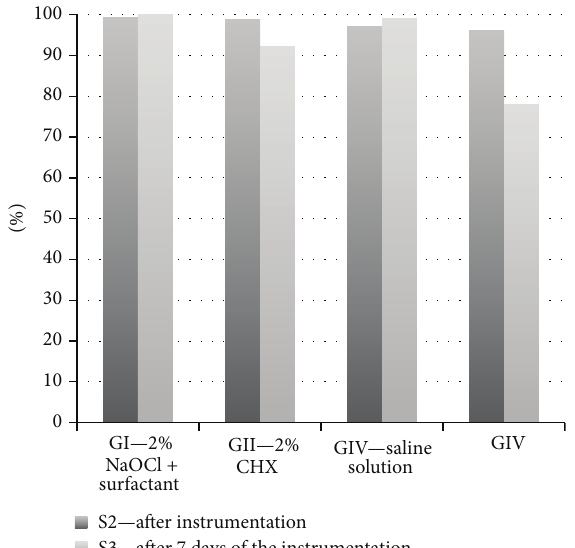
Figure 1: Descriptive analysis of the reduction percentages in the first and second samplings (S2 and S3) in relation to the initial sampling